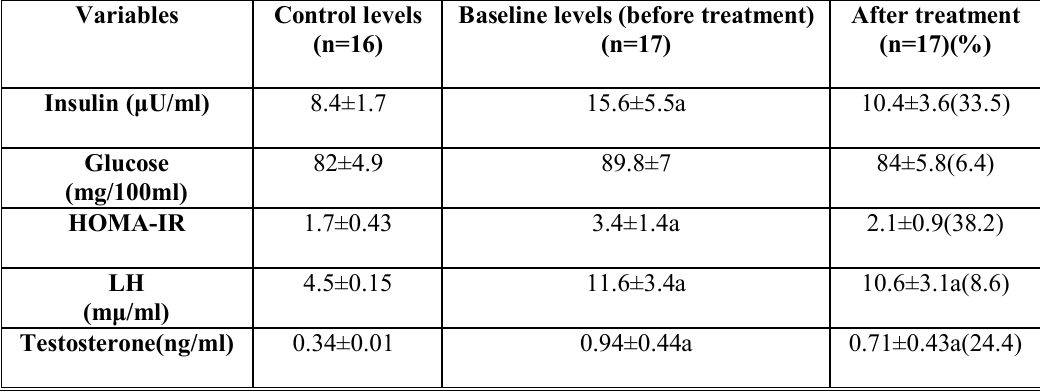
Table (2): Effect of treatment of rosiglitazone(4mg/day) on levels of insulin, glucose, HOMA- IR,LH and testosterone in